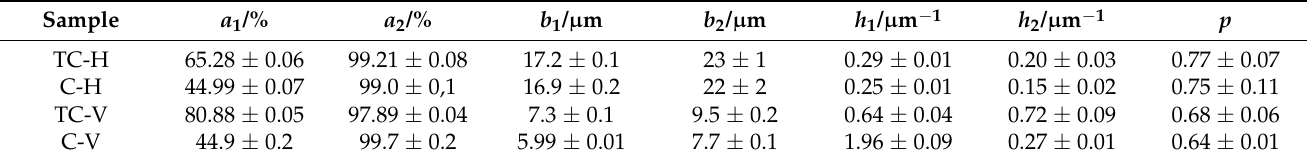
Table 3. Parametric values of bi-logistic fit function arguments for thermochromic horizontal edge (TC-H), conventional horizontal edge (C-H), thermochromic vertical edge (TC-V), and conventional vertical edge (C-V).